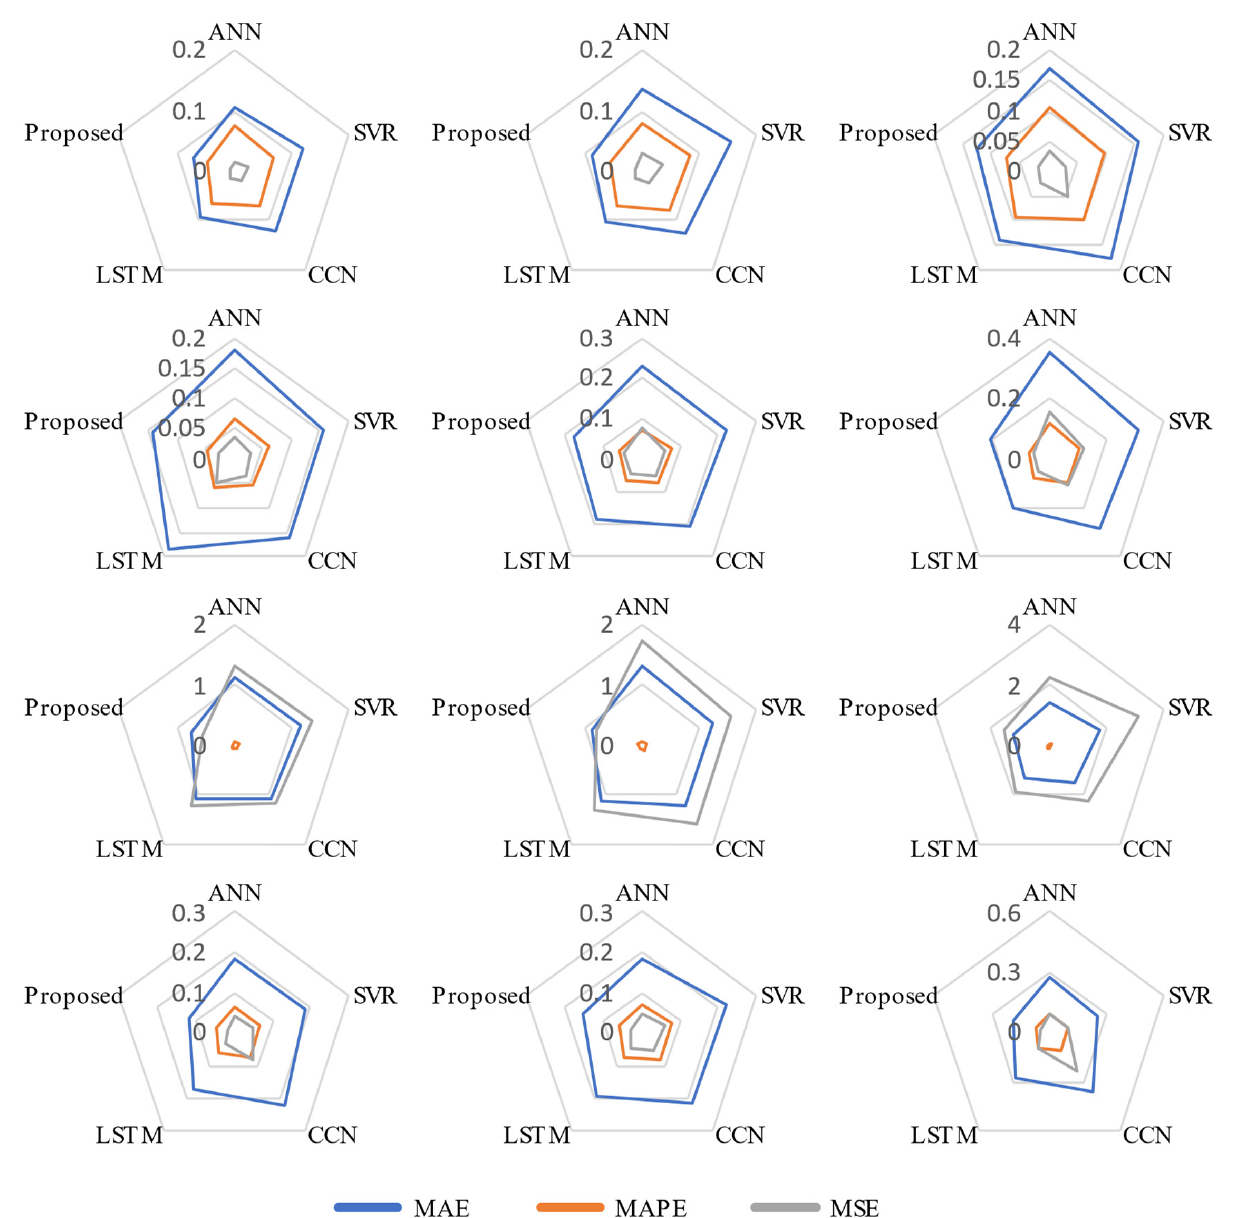
Figure 7. Forecasting results of SSA-CCN-ATT and other individual models in four datasets.